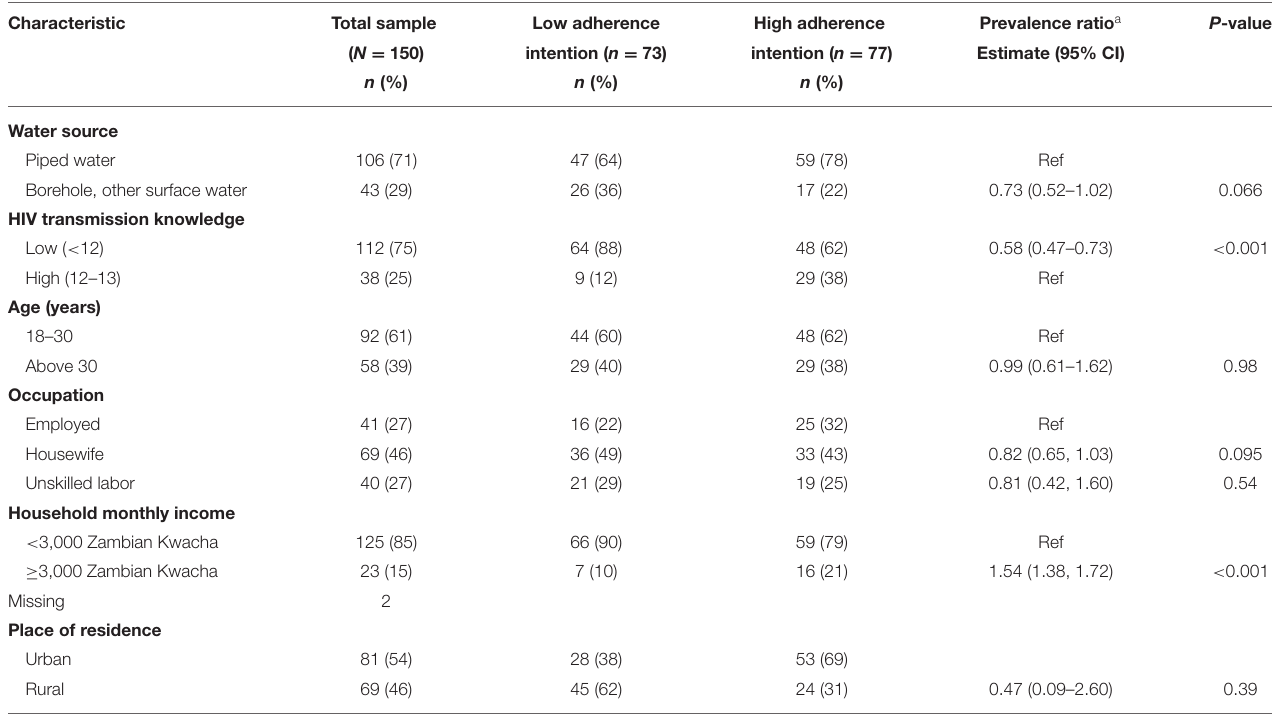
TABLE 1 | Sample characteristics by adherence intention group ( N =